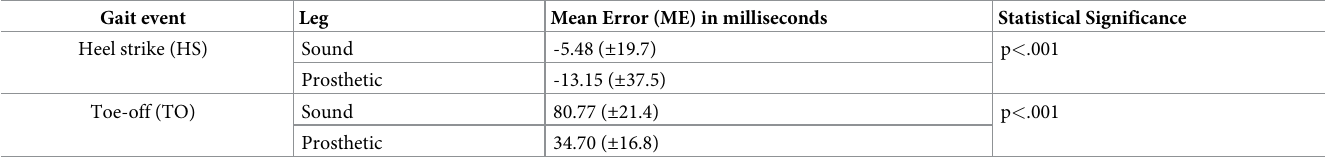
Table 2. Mean error values for heel strike and toe-off events. Gait